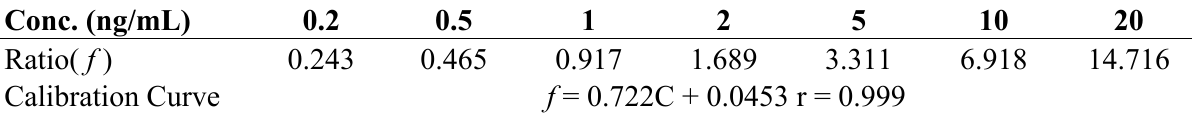
Table 1. Calibration curve of clenbuterol by ASSR.